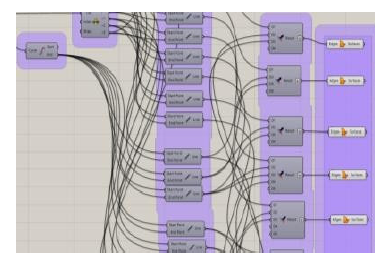
Figure 18. Alternative 1, folding mechanism. Development.